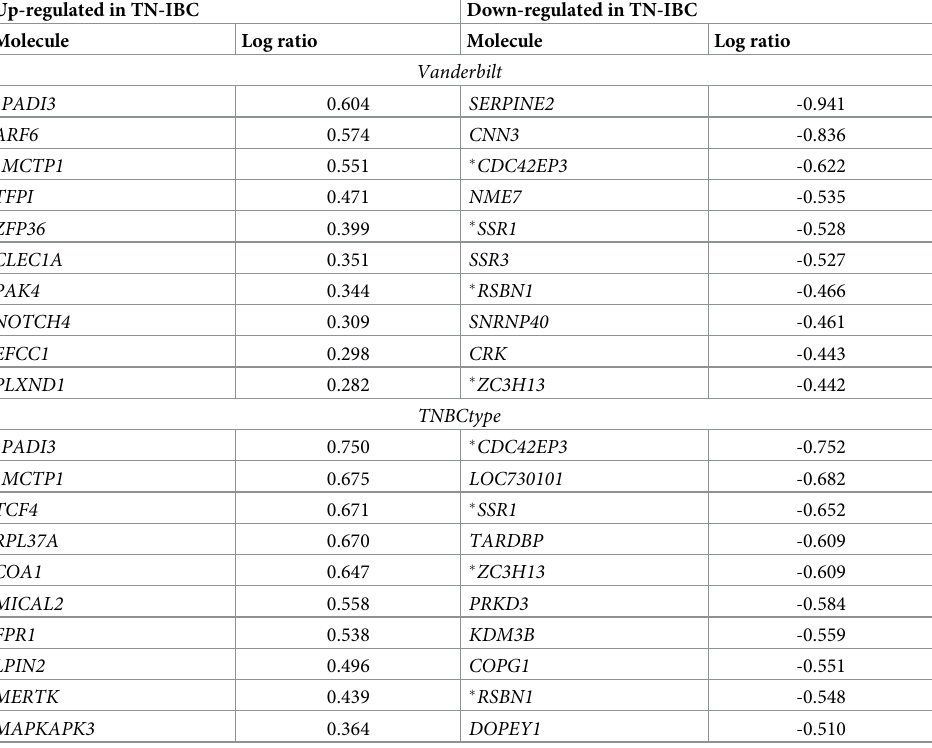
Table 2. Top 10 up-regulated and down-regulated genes in non-MSL TN-IBC versus non-MSL TN-non-IBC a . Up-regulated in TN-IBC